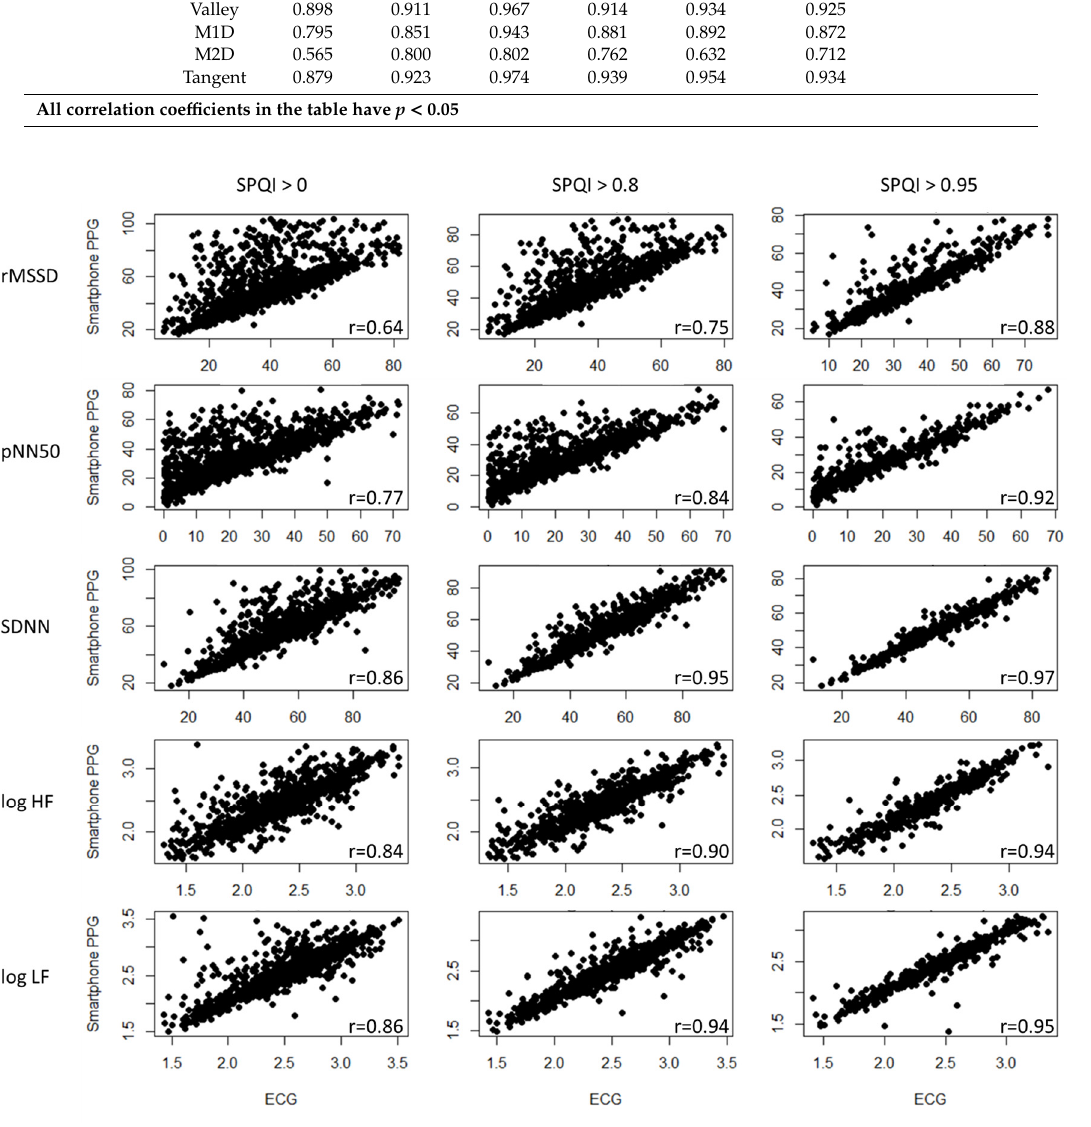
Figure 3. Scatter plot and correlation coe ffi cients of smartphone PPG (with Tangent) and the reference ECG for the HRV measurements.